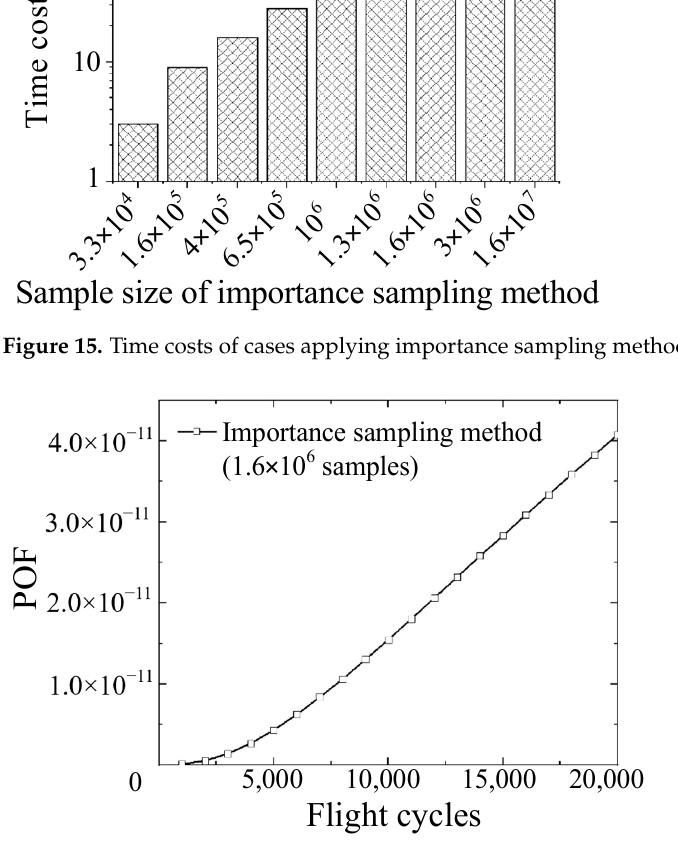
Figure 16 . Convergence result for the importance sampling method with 1.6×10 6 sample size.